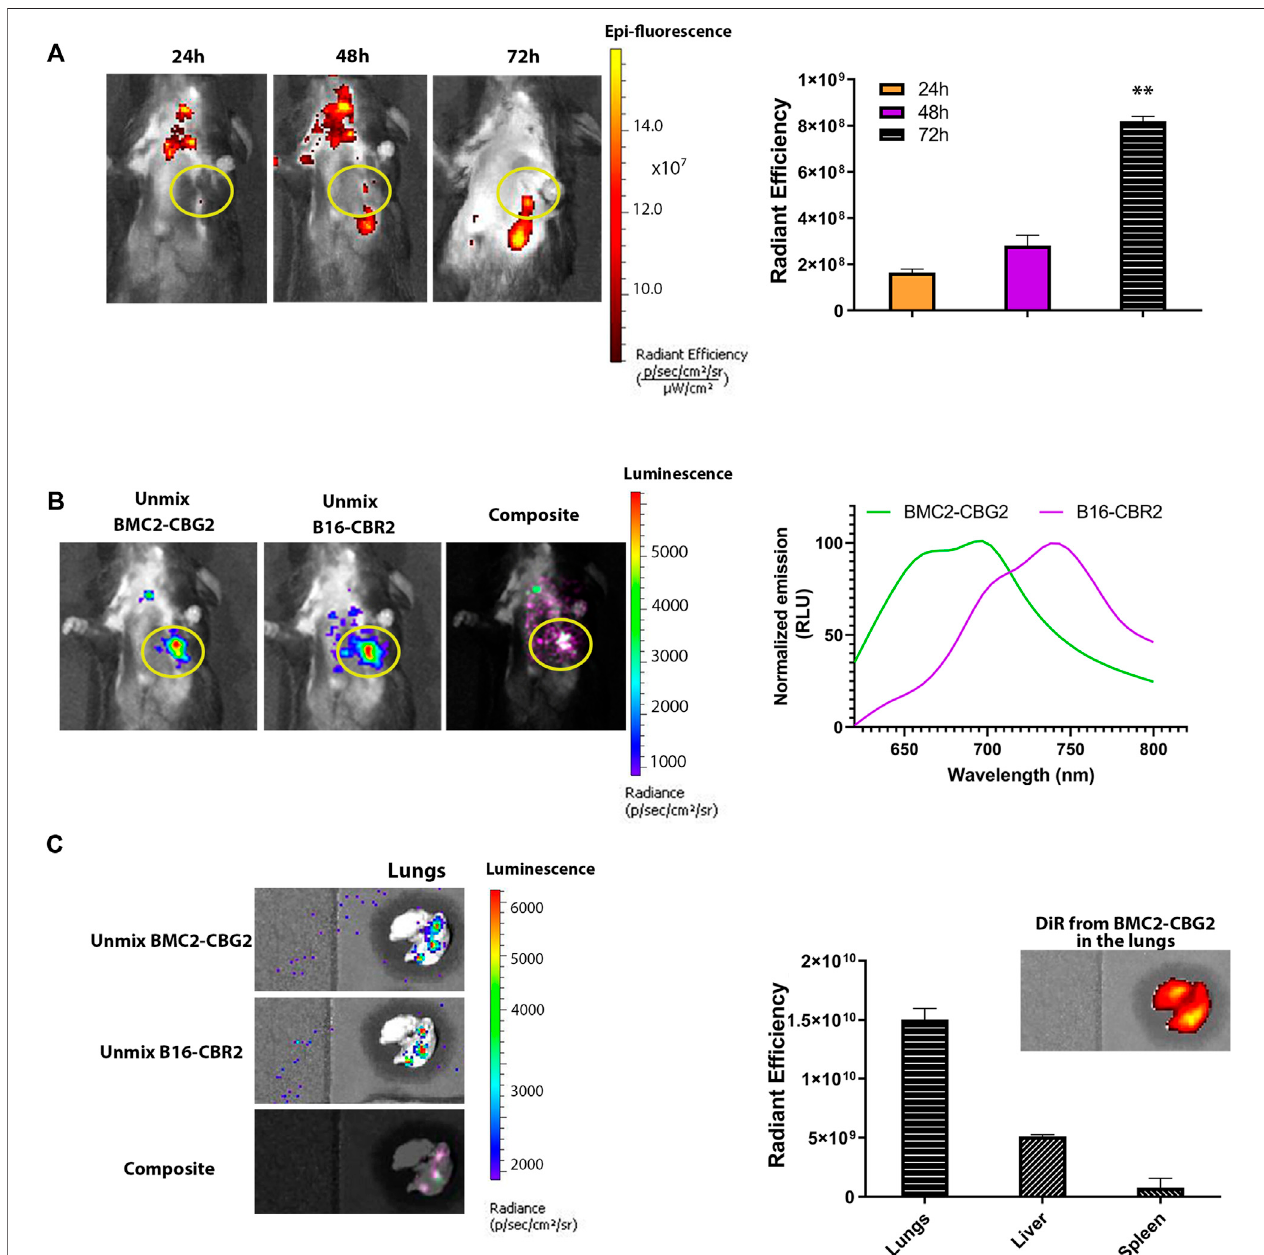
FIGURE 3 | Engineered macrophages enable in vivo visualization of the metastatic tumor model by BLI. (A) Fluorescence imaging of mice bearing B16-CBR2 metastatic cancer cells ( n = 3 mice). After metastatic tumor establishment, C57BL/6 mice were injected with 10 million BMC2-CBG2 macrophages pre-labeled with the DiR near-infrared dye. Fluorescence imaging was performed at 24, 48, and 72 h post BMC2-CBG2 administration (left panel). Fluorescent outputs registered from the lungs wererecordedand plotted inthe right panel, demonstratingthat BMC2-CBG2macrophages accumulate at thetumor site mainly at 72 h after BMC2-CBG2 macrophage administration. The ROI region for the tumor site is marked in the yellow circle. The bar graph shows mean fl uorescence intensity ( n = 3 mice). Signi fi cance wasregistered for mean values of 24- and 48-h groups versus mean values of the 72-h group. (*) p < 0.05 wascalculated by one-way ANOVA followed by Tukey ’ s test. Error bars represent ±SD. (B) Representative BL spectral unmixing of a mouse engrafted with metastatic B16-CBR2 melanoma ( n = 3) (left panel). Mice ( n = 3) were imaged 48 h after the injection of 10 million BMC2-CBG2 macrophages pre-labeled with the DiR near-infrared dye. Images were acquired 15 min after NH 2 -NpLH2 substrate injection. The fi lter selected for the green spectral unmixing (BMC2-CBG2) was set at 700 nm, and for the magenta spectral unmixing (B16-CBR2), the fi lter wassetat740 nm.SpectralpropertiesofBMC2-CBG2macrophagesandB16-CBR2melanomawiththeNH 2 -NpLH2substratearedepictedintherightpanel.TheROI regionforthetumor siteismarkedintheyellowcircle. (C) Representativeimagesof exvivo spectralunmixingofthelungs.ThegreencolorwasusedforunmixedBMC2- CBG2 macrophages and magenta color for unmixed B16-CBR2 melanoma tumors. Colocalized bioluminescent signals for BMC2-CBG2 and B16-CBR2 cells in the lungs resulted in overlapped colors (light pink), as shown in the composite image (left panel). Radiant ef fi ciency values for DiR-labeled BMC2-CBG2 macrophages were measured in the lungs, livers, and spleens and are depicted in the right panel. FL emissions for the DiR fl uorescent dye were recorded from the lungs, liver, and spleen, selecting the DiR fi lters for excitation at 710 nm and emission at 760 nm. The bar graph shows the mean fl uorescence intensity. Error bars represent ±SD.